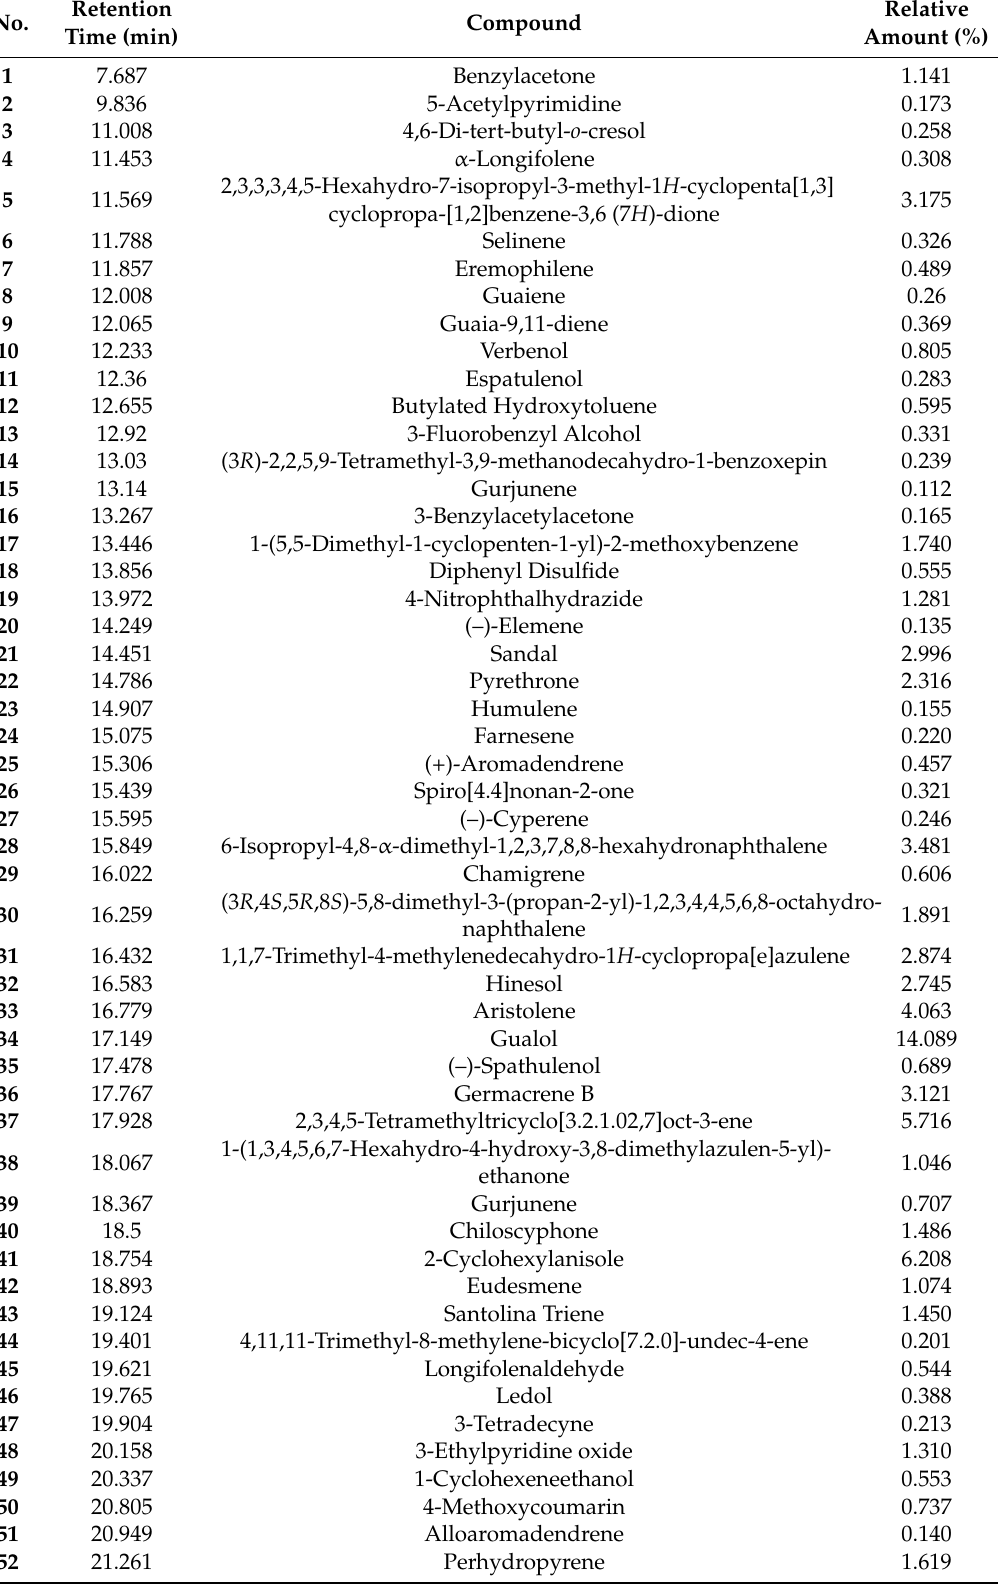
Table 1. Chemical compositions and relative amounts of agarwood essential oil